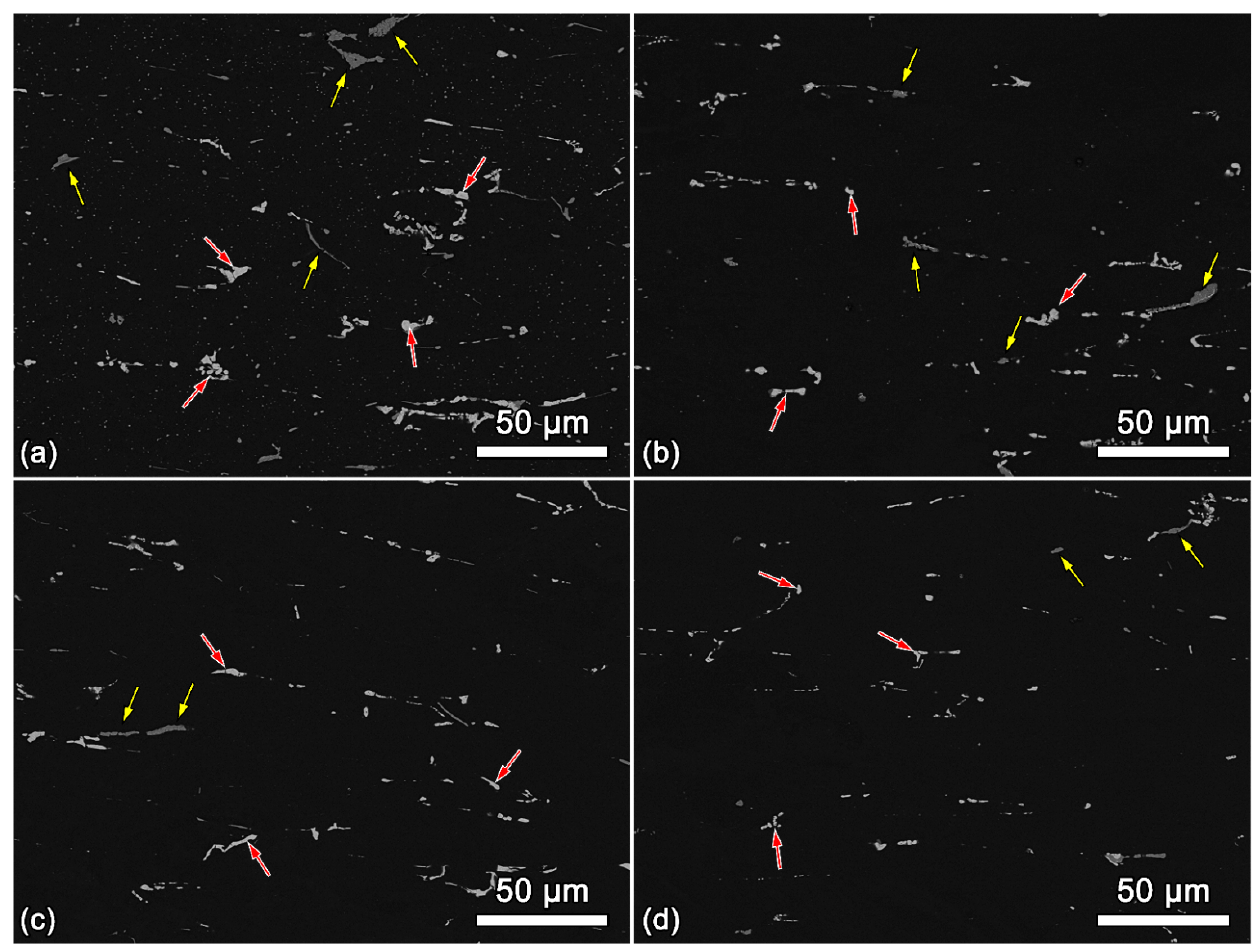
Figure 5. Backscattered electron microscopy recorded from ( a ) sample I, ( b ) sample II, ( c ) sample III, and ( d ) sample IV. Two coarse phases are pointed with yellow arrow (Al–Cu–Mn–Fe) and red arrow (Al 2 Cu). Table 1. Chemical composition (at.%) in the Al matrix of the aged Al–Cu–Mg–Mn–Ag alloys. Alloys Cu